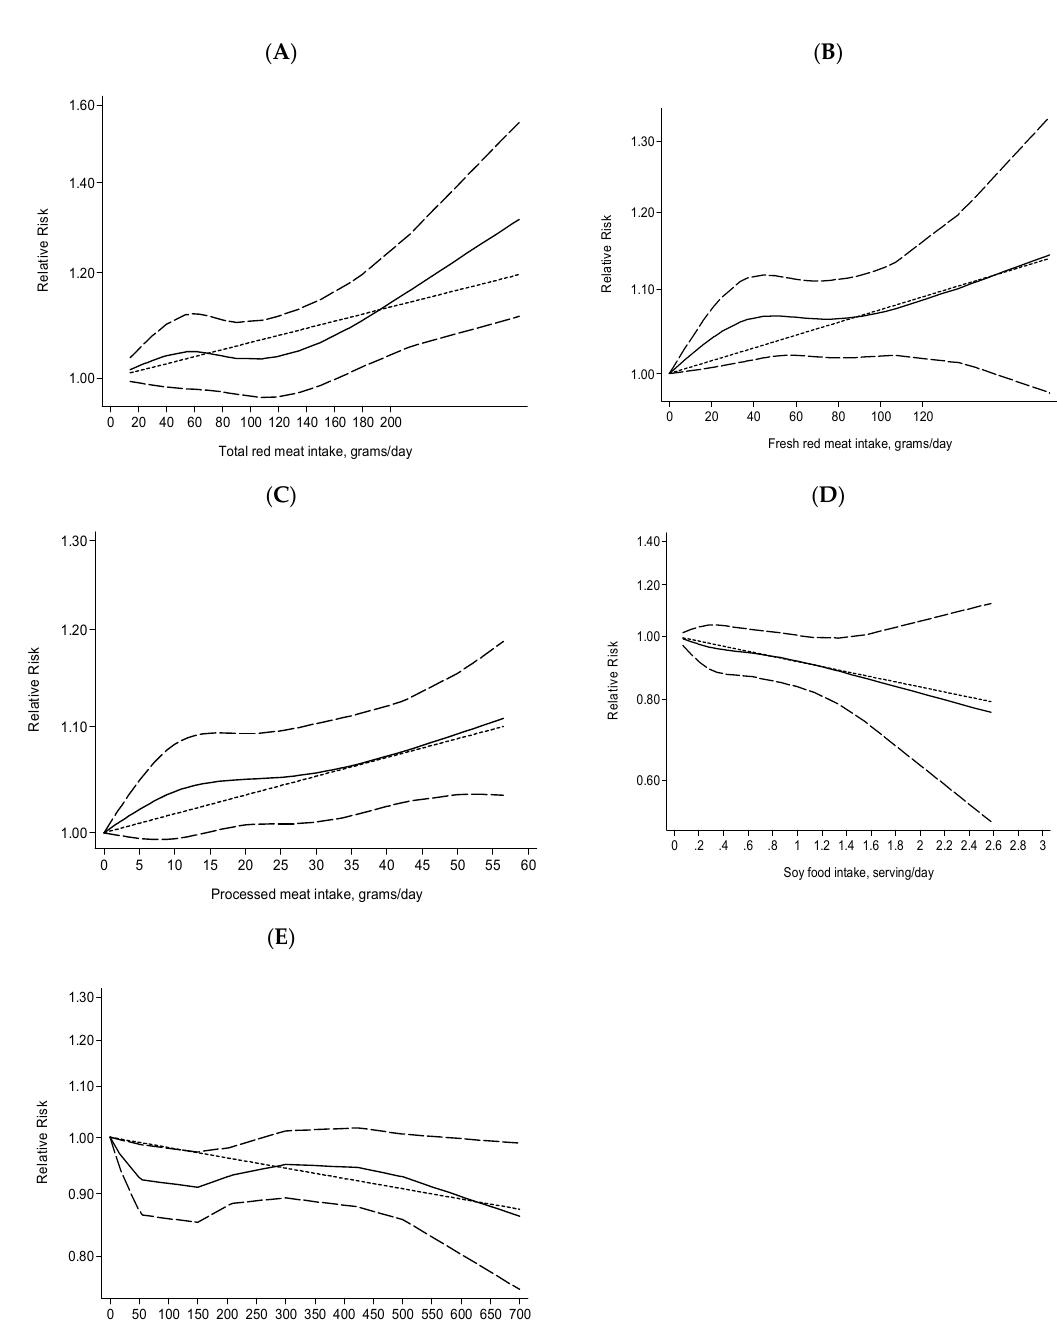
Figure 3. Dose-response analysis of total red meat, fresh red meat, processed meat, soy foods, and skim milk intake and the risk of breast cancer. The solid line represents estimated relative risks (RRs), and dashed lines are their 95% confidence interval (CI). As shown in the figure, total red meat, fresh red meat, and processed red meat are related to an increased risk of breast cancer, whereas soy food and skim milk are related to a decreased risk of breast cancer. ( A ) Total red meat; ( B ) Fresh red meat; ( C ) Processed meat; ( D ) Soy foods; ( E ) Skim milk.